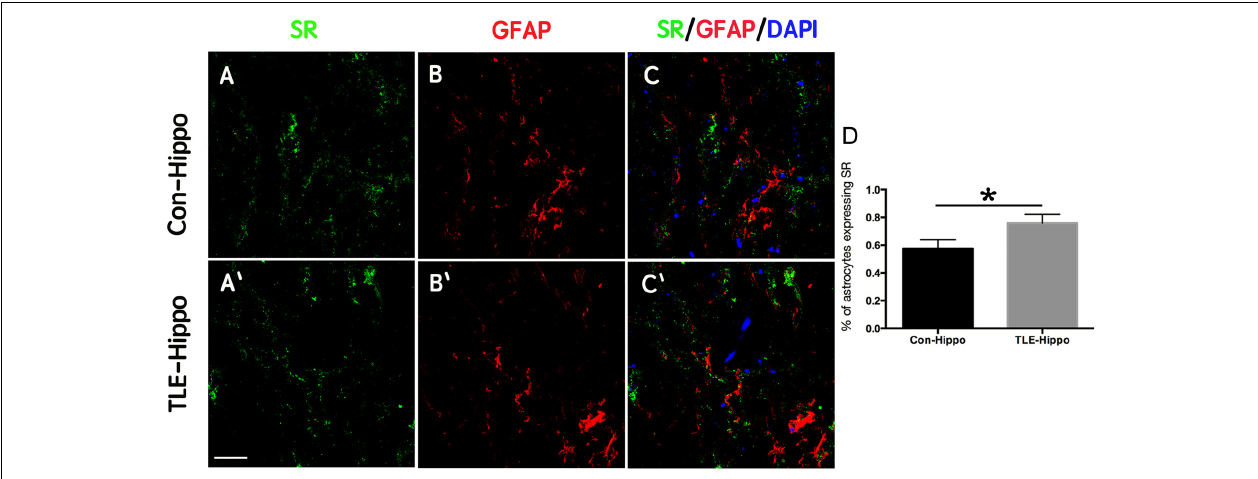
FIGURE 2 | Expression of SR in TLE patients. (A–C) Double-immunostaining of GFAP/SR in the hippocampi of control and TLE patients. (D) Quantification of astrocytes expressing SR in the hippocampi of control and TLE patients. The expression of SR was up-regulated in the hippocampi of TLE patients. ∗ P < 0.05. Bars = 50 µ